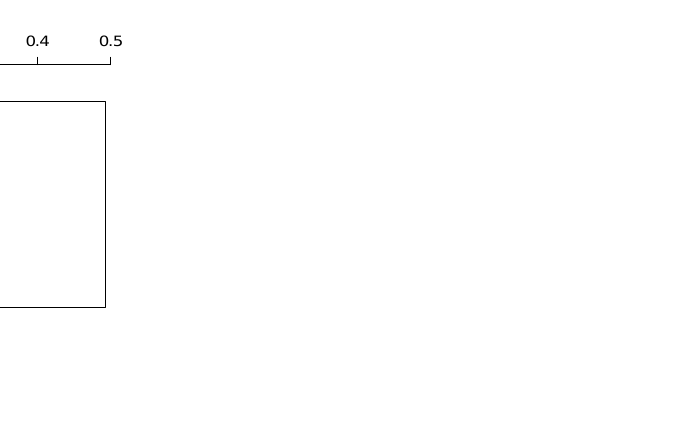
Figure 5. Example of hierarchical clustering procedure.